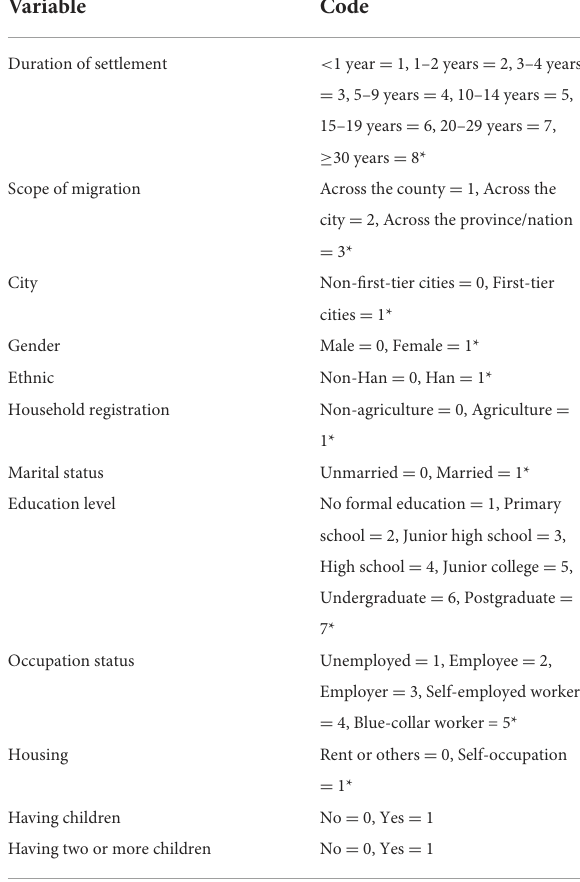
TABLE 1 Coding of categorical